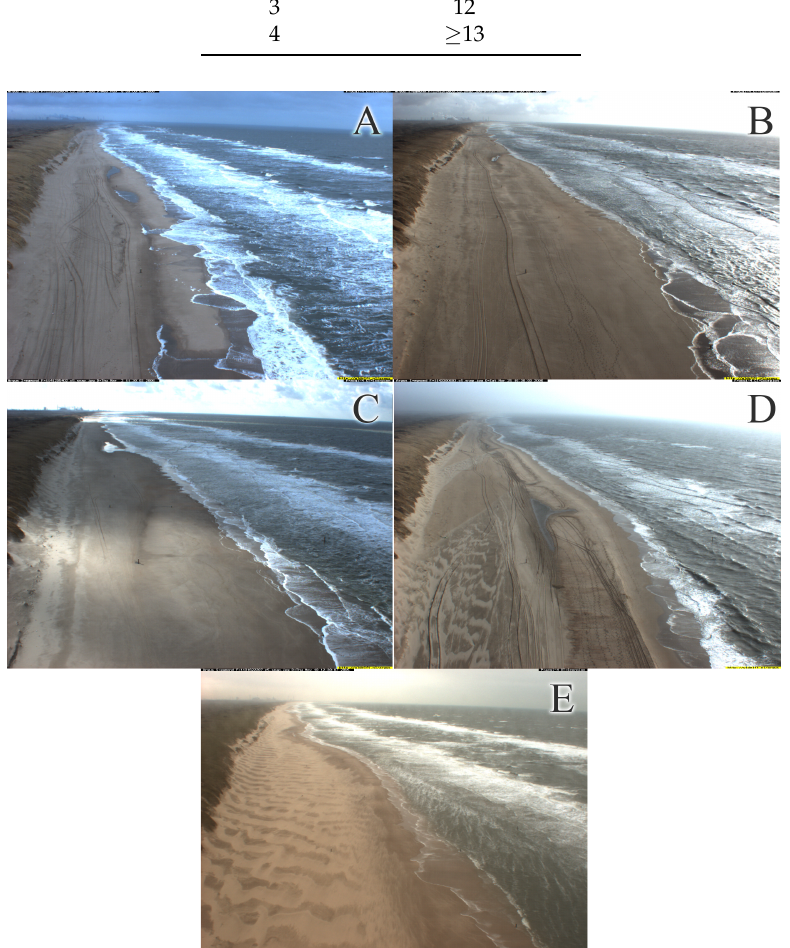
Figure 4. Examples of snapshots made by the north-facing camera and classified according to their visual signs of aeolian activity, where class 0 shows no signs of transport ( A ); class 1 shows very small signs of transport, like single moving patches of sand or a handful of streamers ( B ); class 2 has more of these sand patches, but they have not formed rows of sand strips; class 3 does have rows of sand strips, but they cover a patchy area; and class 4 features sand strips that cover most of the beach, often in combination with high streamer activity The date of the image and wind conditions were: 08-02-2006, U = 7 m/s, θ = − 23 ◦ ( A ); 05-03-2006, U = 8 m/s, θ = − 23 ◦ ( B ); 02-03-2006, U = 9 m/s, θ = 17 ◦ ( C ); 25-03-2006, U = 10 m/s, θ = 47 ◦ ( D ); 10-11-2005, U = 12 m/s, θ = 57 ◦ ( E ); where θ = 0 ◦ is cross-shore, θ = − 90 ◦ is the alongshore wind coming from the north, and θ = 90 ◦ is alongshore from the